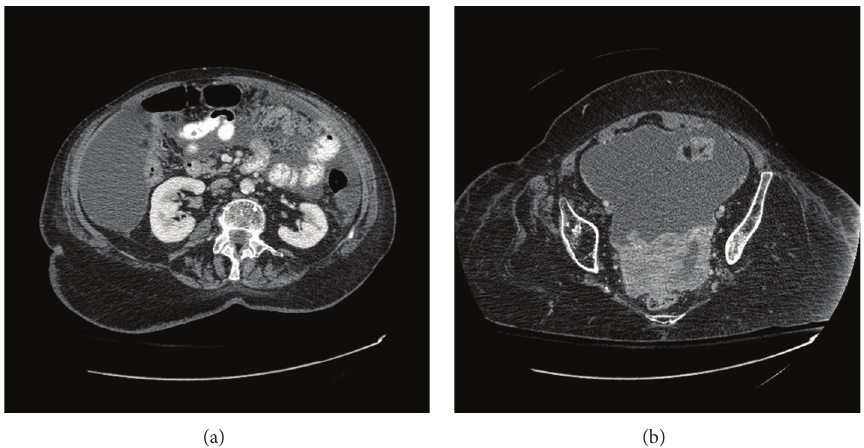
Figure 2: CT scan of the abdomen and pelvis shows ascites, nodularity in the peritoneal cavity (a), and prominent adnexal tissues (b).